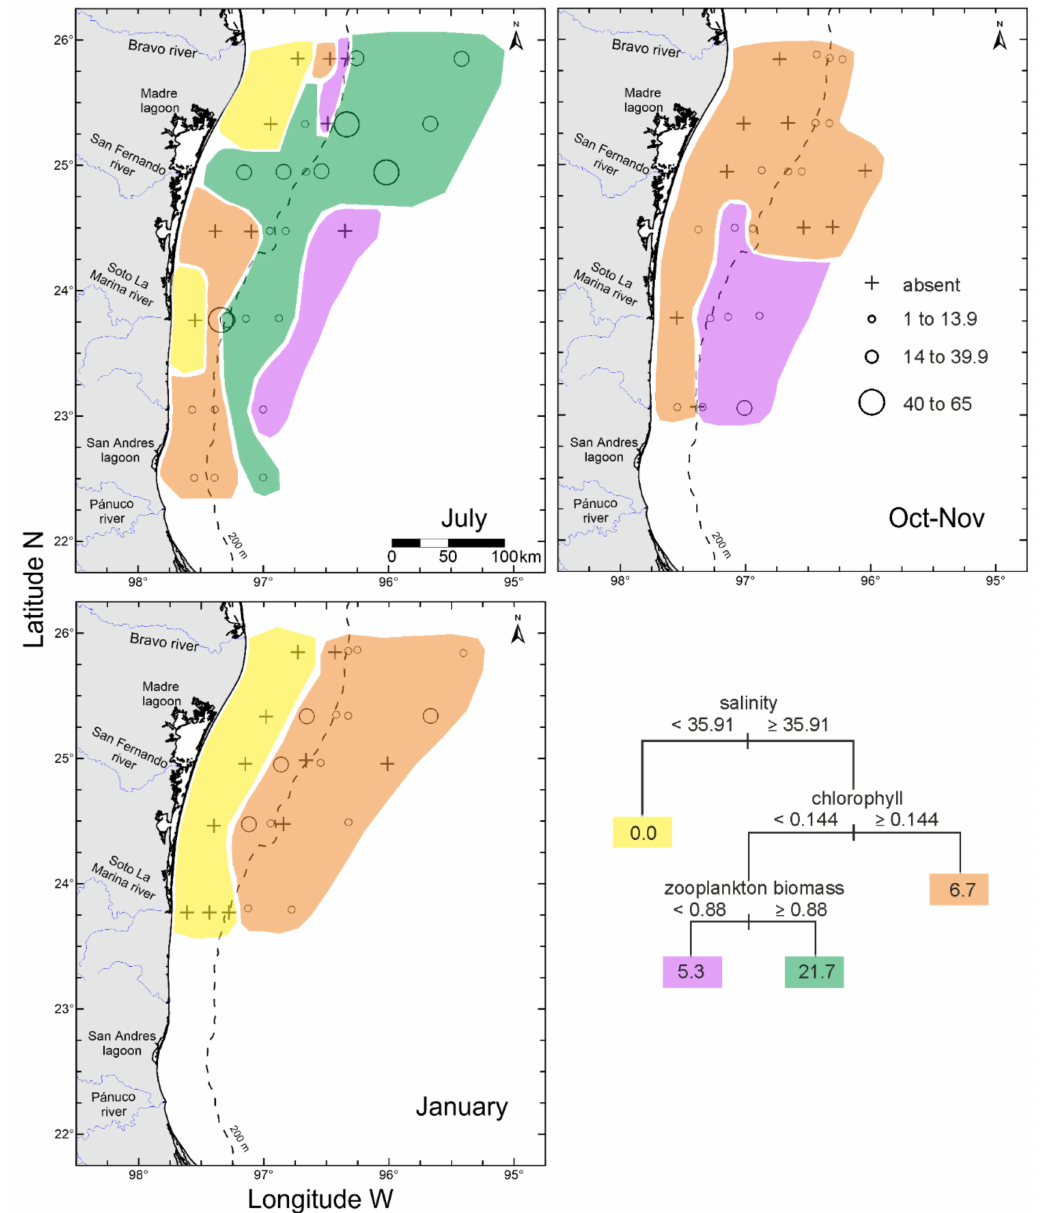
Figure 9. Abundance (ind 100 m − 3 ) of Lucifer typus in the western Gulf of Mexico and results of the regression tree analysis showing the mean abundance value of the response variable at the end of the